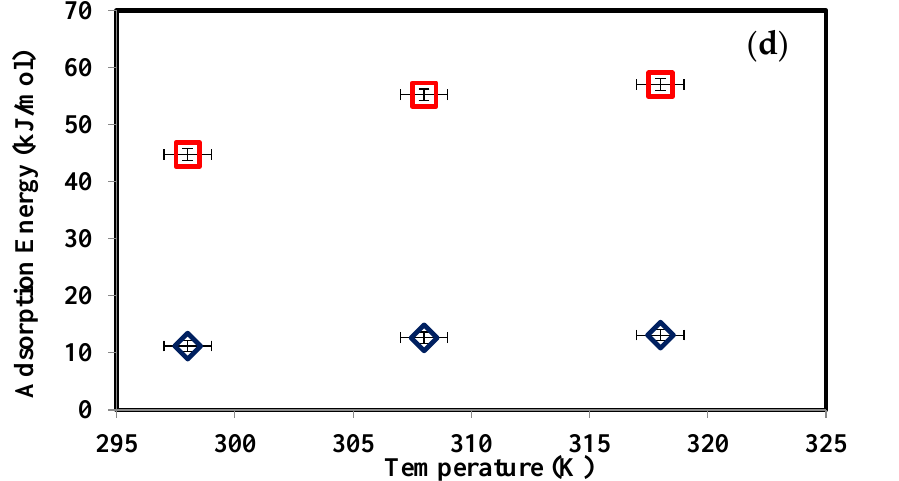
Figure 6. Graph of ( a ) number of molecules per site ( n ), ( b ) Nm, ( c ) Q sat , and ( d ) adsorption energies vs. temperature. Table 5. Comparison of adsorption capacity of PbO@MgZnO with other adsorbents.